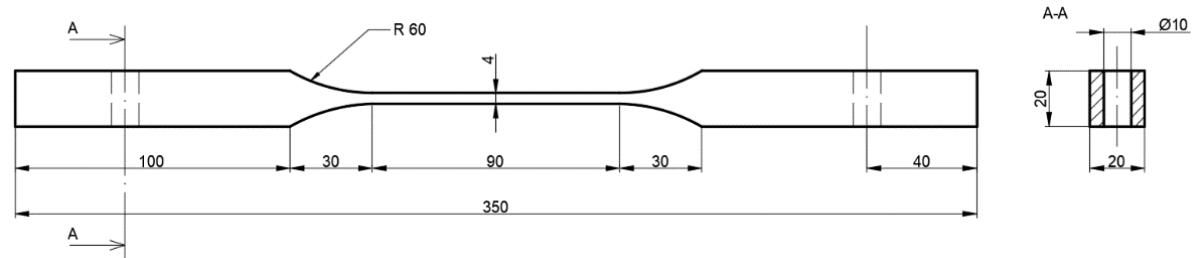
Figure 3. Shape and dimensions of test samples for tensile test according to [14].